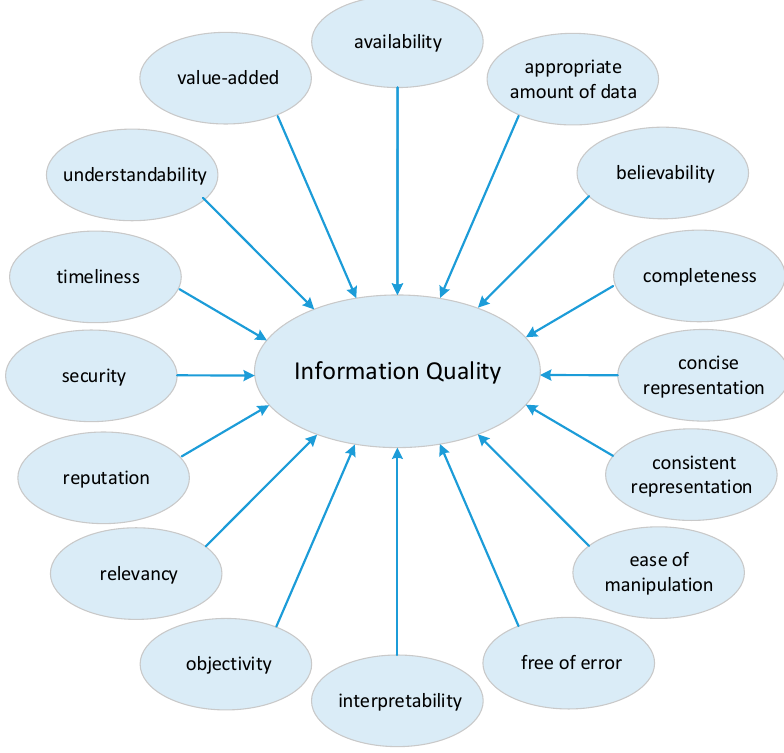
Figure 1. Information quality components (own study based on [25,26]).